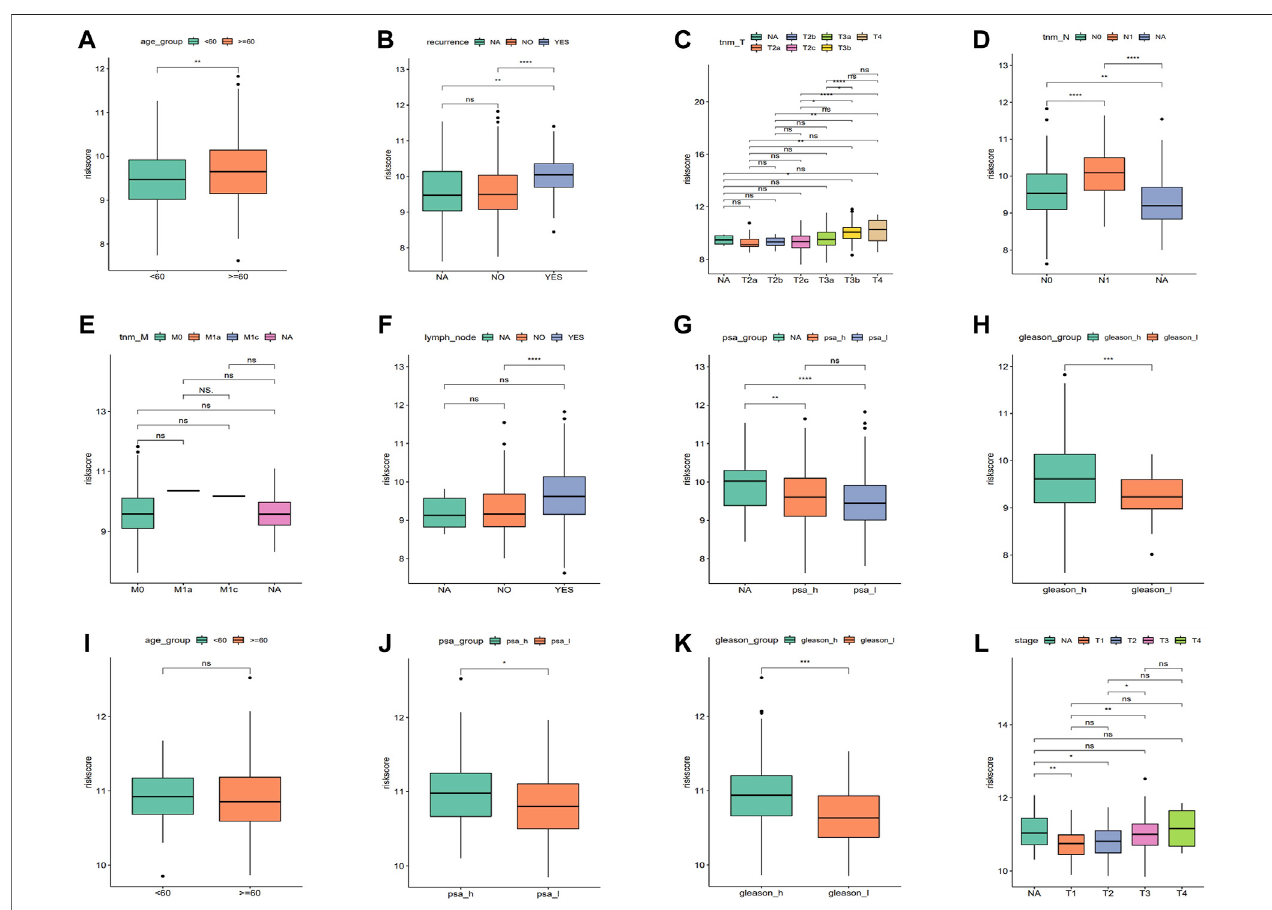
colorectal cancers displayed strong cytoplasmic staining. A cytoplasmic positivity. Squamous cell carcinomas, gliomas, renal, and gastric cancers were generally negative. For